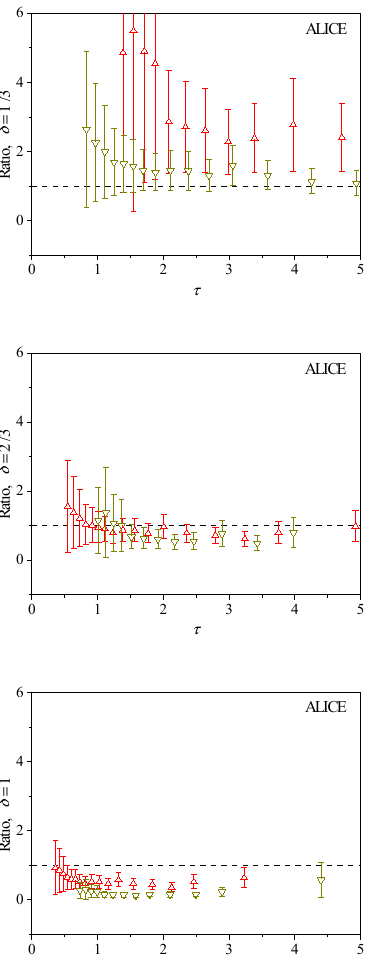
and plot them for di (cid:11) erent (cid:14) as functions (cid:28) in Fig. 6. In the left panel we plot ALICE data where red up-triangles points correspond to c 2 = 20 (cid:0) 40% and the dark green down-triangles to c 3 = 40 (cid:0) 80%. Geometrical scaling is achieved when R c from Fig. 6, this happens indeed for (cid:14) (cid:25) 2 = 3. The same ratios for PHENIX data are plotted in the right panel of Fig. 6 where red triangles correspond to c 2 = 20 (cid:0) 40%, dark-green ones to c 3 = 40 (cid:0) 60% and blue ones to c 4 = 60 (cid:0)